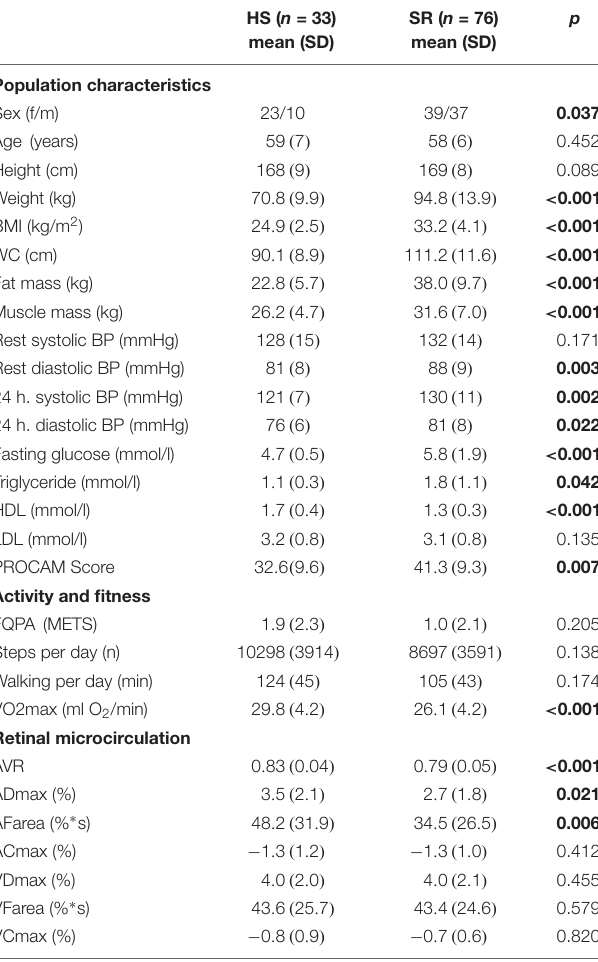
TABLE 2 | Group differences between healthy active and healthy sedentary individuals.